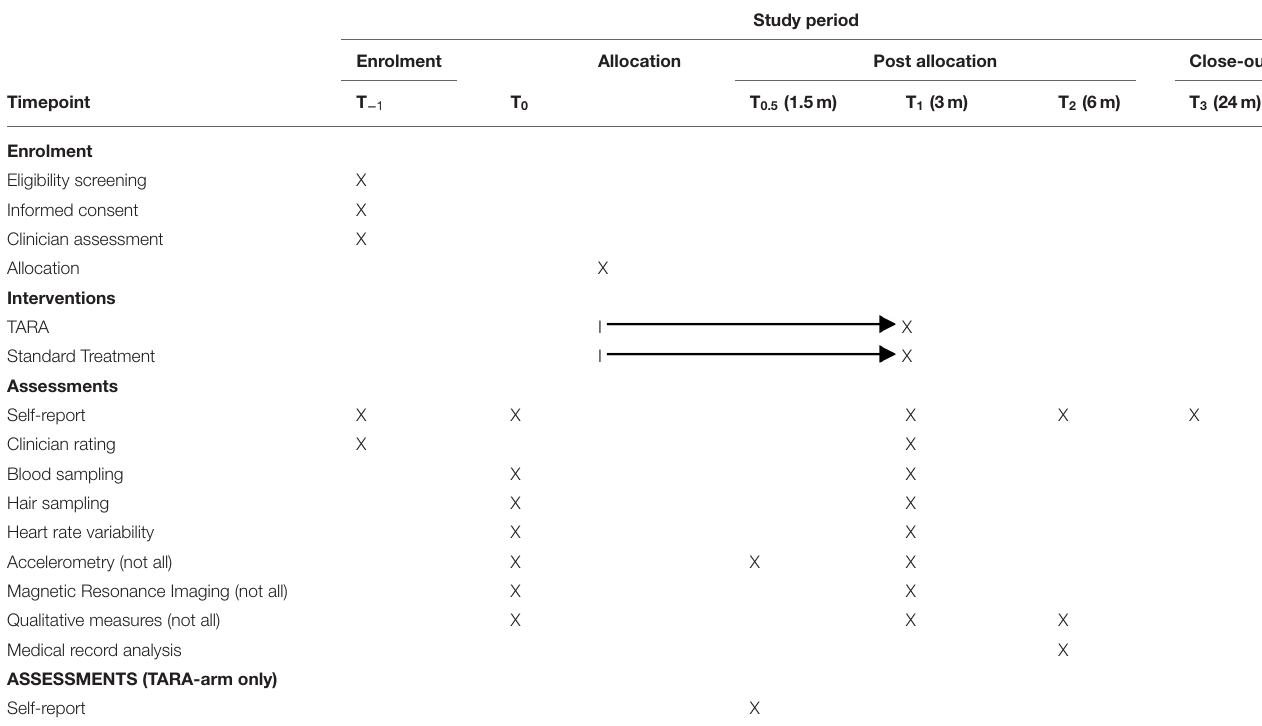
TABLE 1 | Schedule of enrolment, interventions, and assessments.